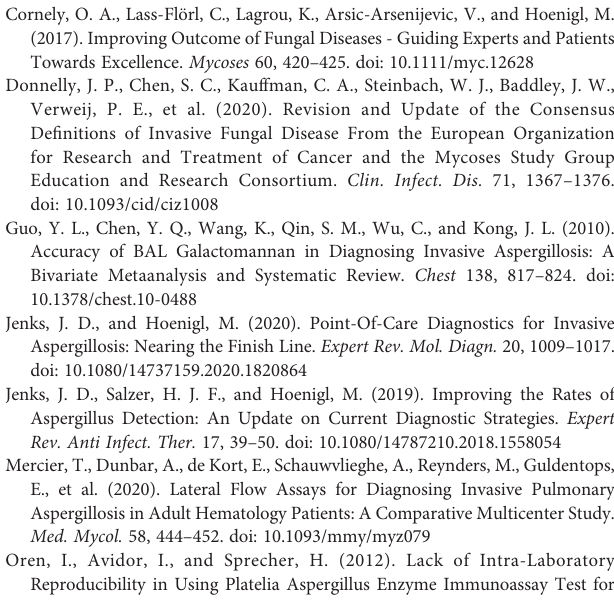
VIDAS ® GM Platelia ™ Aspergillus